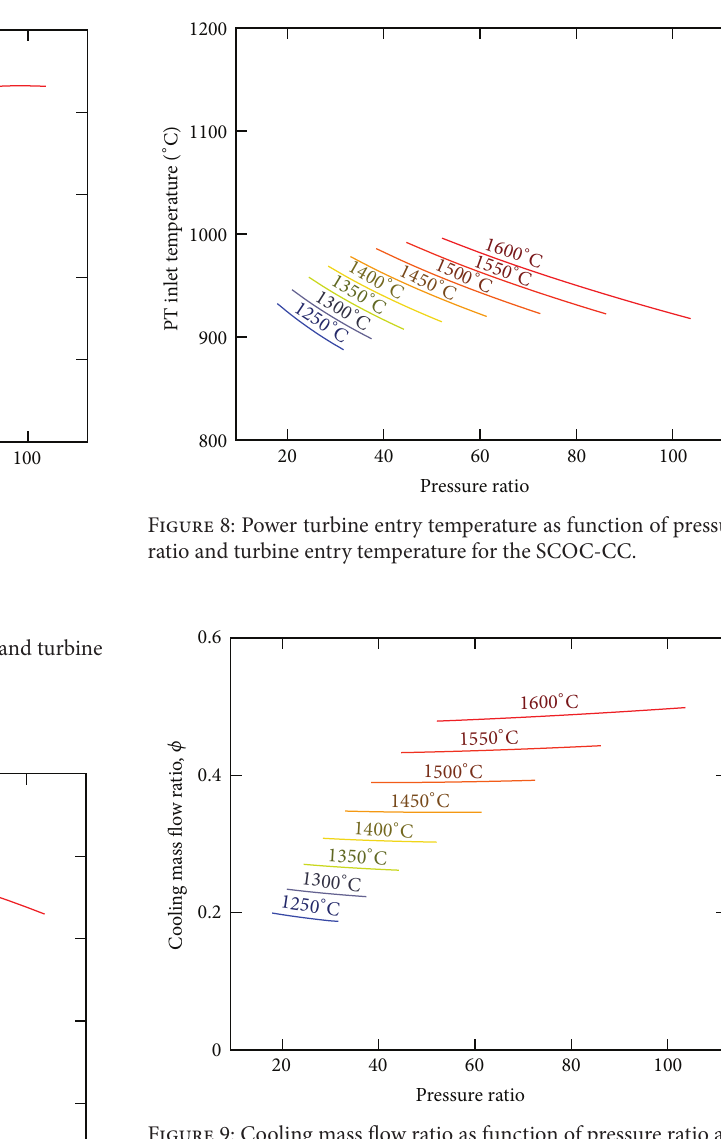
Figure 9: Cooling mass flow ratio as function of pressure ratio and the turbine entry temperature for the